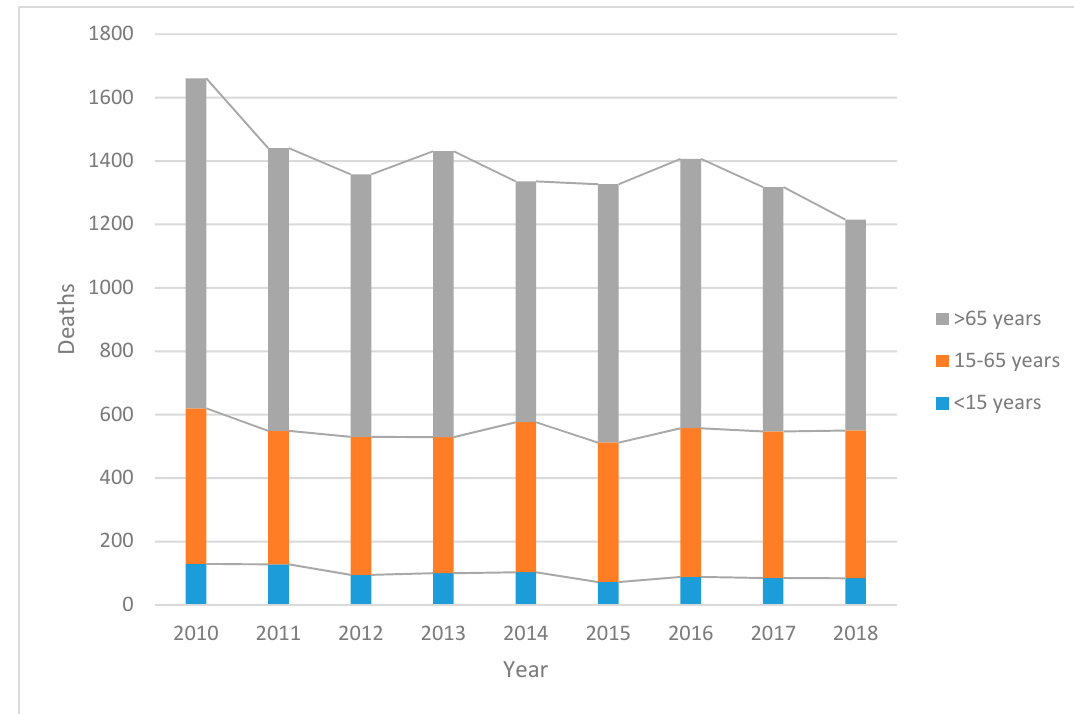
Figure 1. Number of deaths due to asthma in Mexico from 2010 to 2018 ( n = 87,726). Table 1. Relative risk ratio of death in hospital environment due to asthma in Mexico between 2010 and 2018.